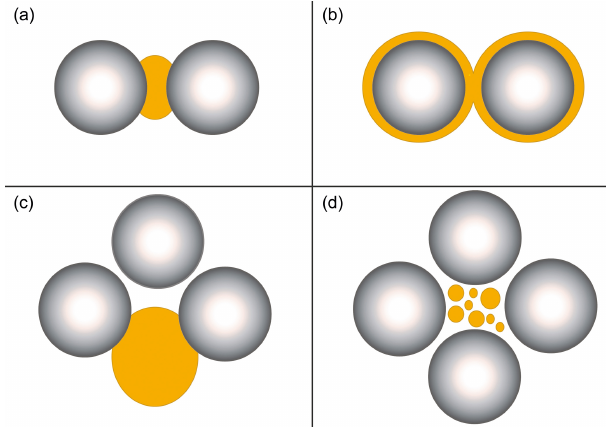
Figure 1. Review of the established conceptual models (grains are grey and GH are orange), with (a) cementation – GH cements the grains; (b) encrustation – GH coats the grains; (c) matrix-supporting – GH is part of the sediment matrix; and (d) pore-filling – GH em- ploys the pore space forming crystallites of varying size (modified after Dai et al.,